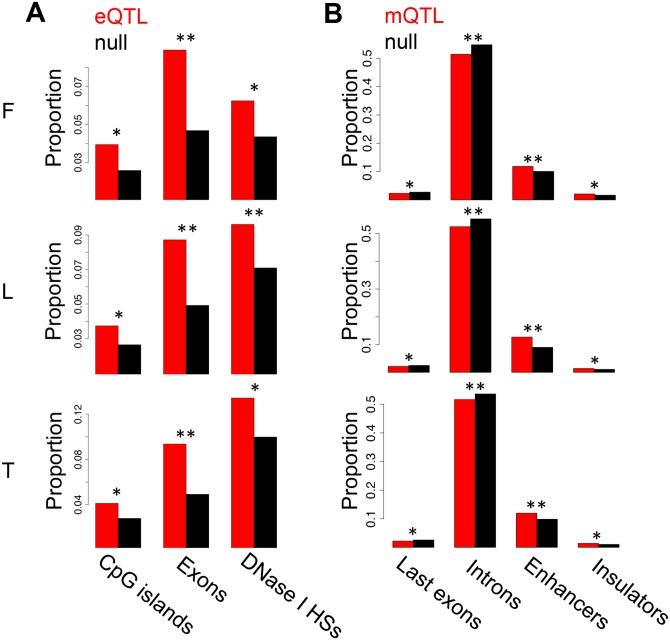
Enrichment of eQTLs and mQTLs in distinct genomic regions.For distinct genomic regions, the proportion of overlapping eQTLs (A) and mQTLs (B) (both in red) was compared to the proportion of overlapping null SNPs (black, see Methods for details). We found significant enrichment of eQTLs in CpG islands, exons and DNase I hypersensitive sites (HSs), and significant enrichment of mQTLs in enhancer and insulator marks, as well as significant depletion in last exons and introns. One star indicates P < 0.05, two stars indicate P < 5E-04, Fisher’s exact test.